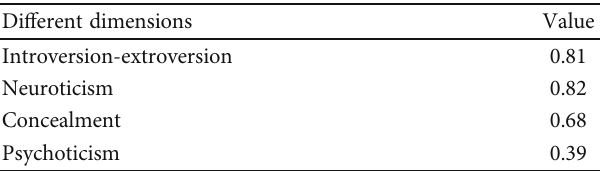
Table 2: Cronbach α coe ffi cient of EPQ-RSC.